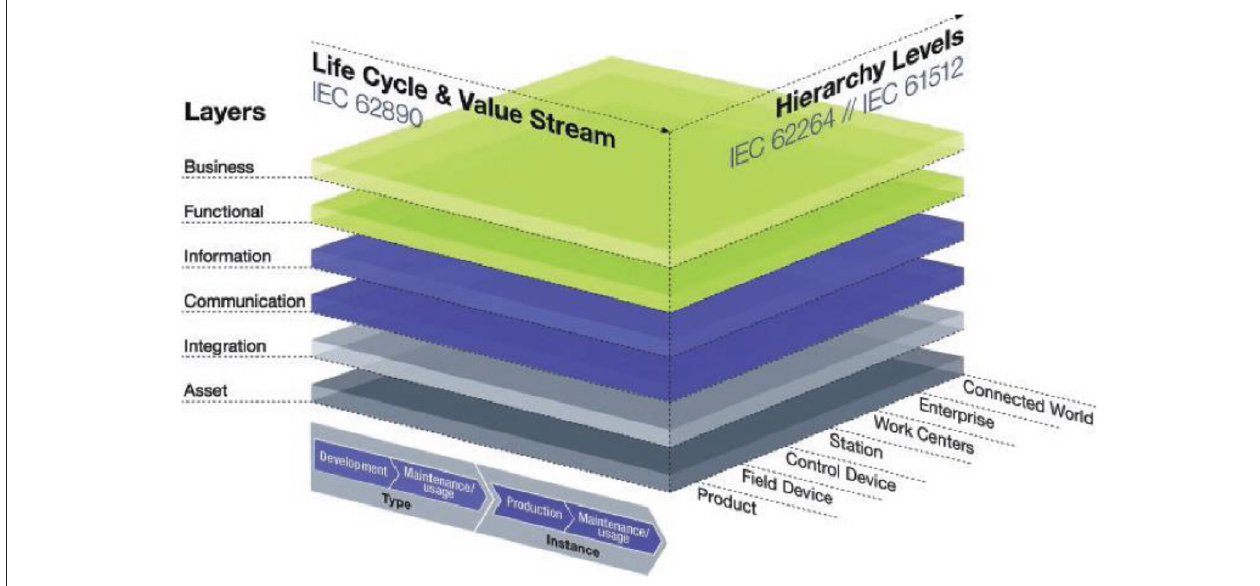
FIGURE 1 | The RAMI 4.0 (Source: Hankel and Rexroth,